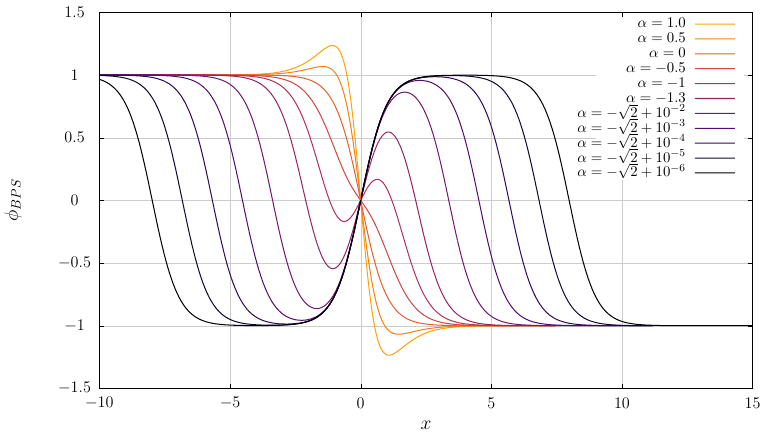
Figure 1 . Solutions of the Bogomolny equation for di(cid:11)erent values of (cid:11) centered at a = 0.